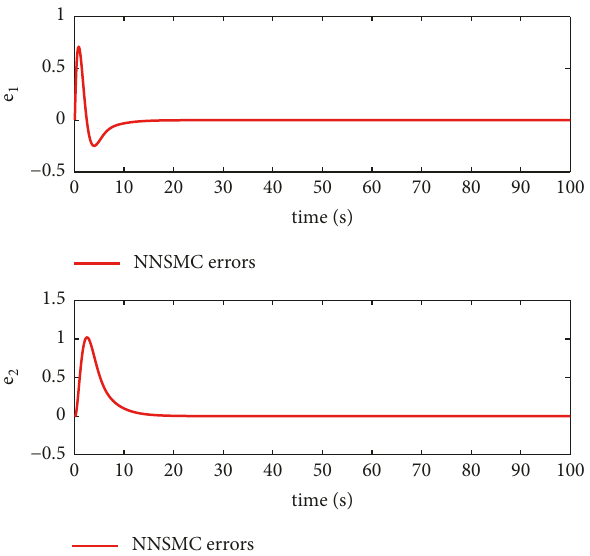
Figure 4: The control results of NNSMC versus PID control.